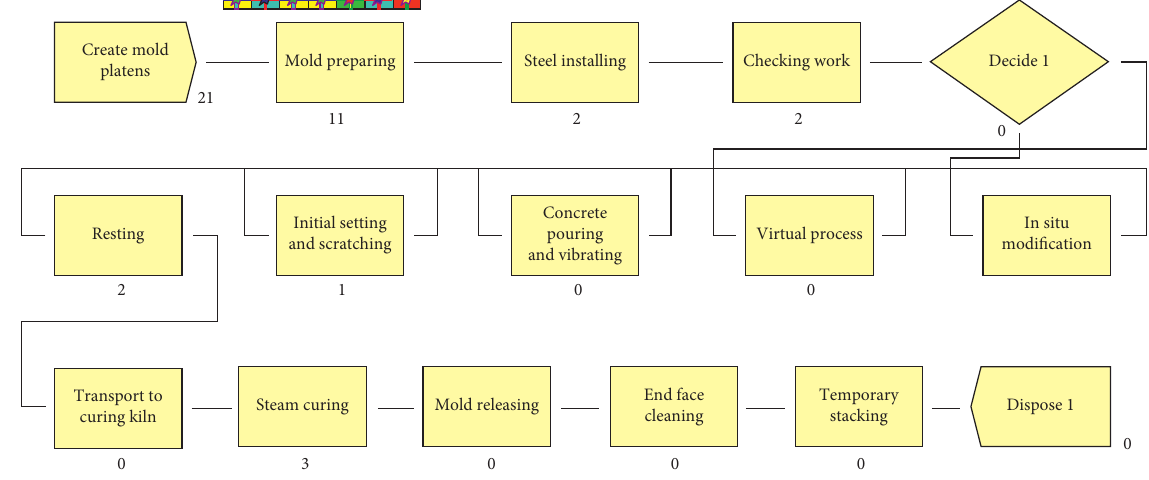
Figure 7: Logic model regarding precast component production.